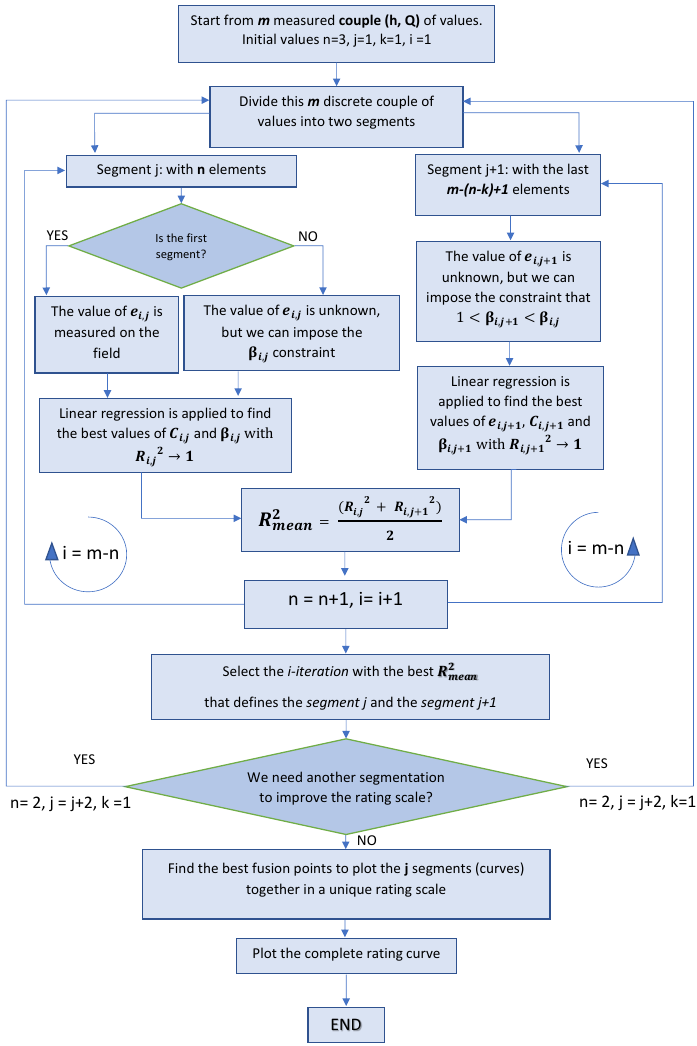
Figure 8. Block diagram: procedure developed to create rating